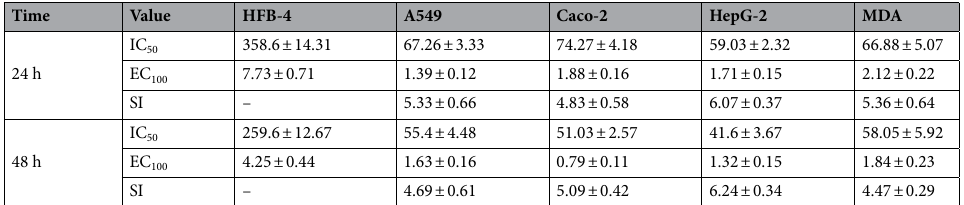
Table 6. IC 50 , EC 100 (μg/mL) and SI values of the biosynthetic ZnO NPs against normal (HFB-4) cells and tumor (A549, Caco-2, HepG-2, and MDA) cells after treatment for 24 h and 48 h. All values were expressed as mean ±